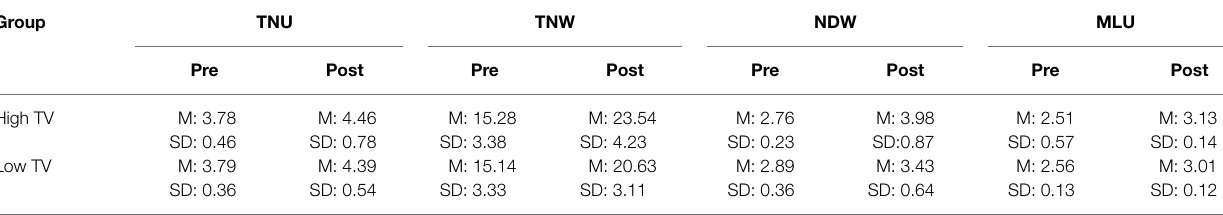
TABLE 4 | Descriptive statistics for background TV.